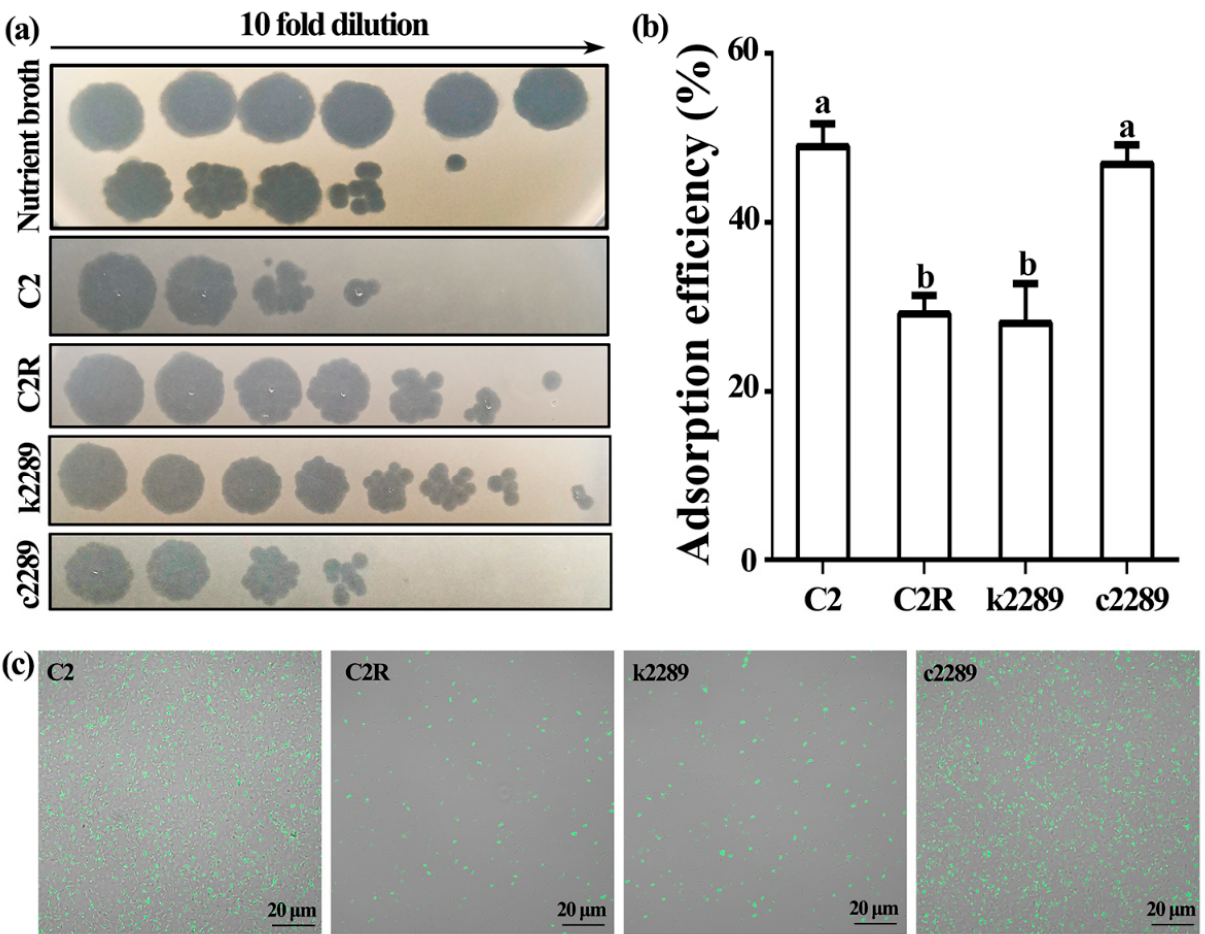
Figure 5. Phage adsorption to wild-type Xoo strain C2, spontaneous phage-resistant mutant C2R, insertional mutant k2289 and complement c2289 after 30 min of incubation. ( a ) Infection of tenfold dilution unabsorbed phage X2 to bacteria. ( b ) Adsorption efficiency of X2 binding to bacteria. Data were presented as means ± standard errors ( n = 3). Columns with different letters are significantly different according to LSD test ( p < 0.05). ( c ) Visualization of SYTO-labeled X2 phage adsorption to bacterial surfaces under a laser scanning confocal microscope.